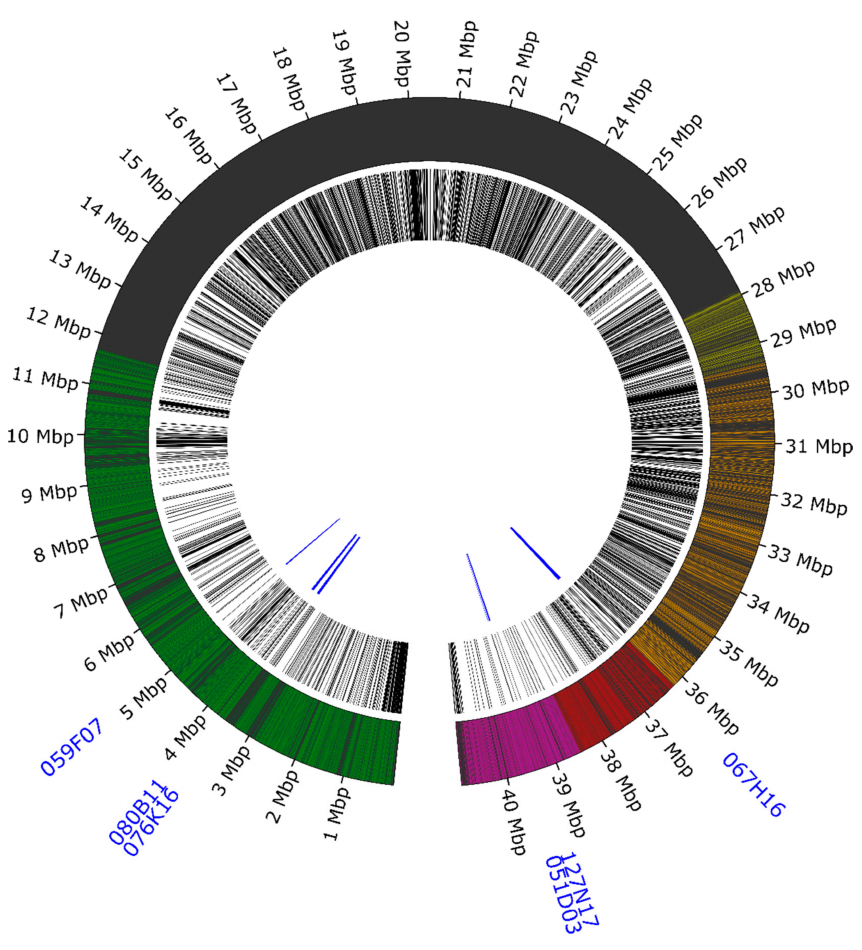
Figure 2. Schematic layout of the oligonucleotide libraries and repetitive sequences in pseudochromosome Lang06. The O1 library is marked in green, the O2 library in red, and the O3 library in yellow. Orange highlights the common region for the O2 and O3 libraries, whereas violet covers the region common to O2 and O4 libraries. Repetitive sequences are shown in black in the middle circle. Bacterial artificial chromosome (BAC) clone localization diagram is shown in blue in the inner circle.